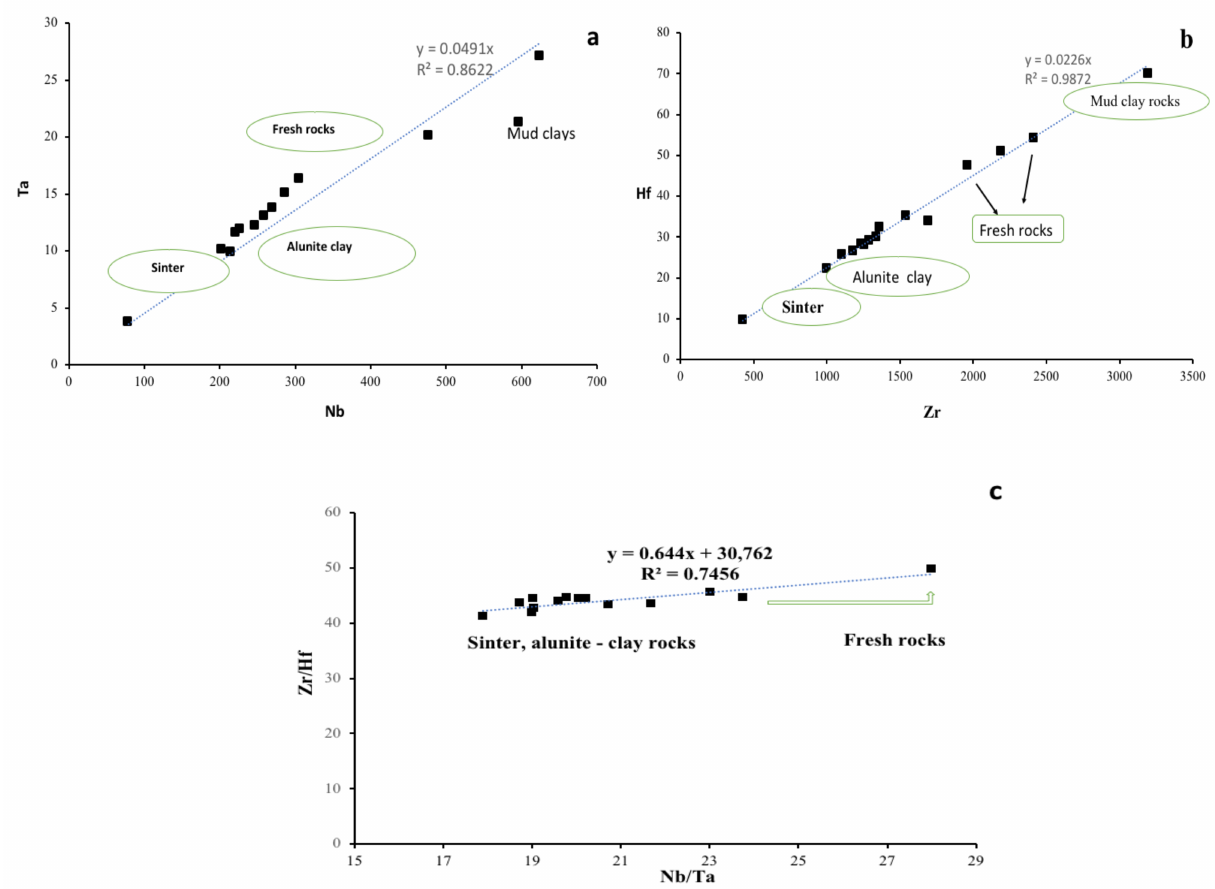
Figure 5. The diagram of Nb vs. Ta ( a ), Zr vs. Hf ( b ) and Nb/Ta vs. Zr/Hf ( c ) corresponding to sinter, alunite-clay and fresh